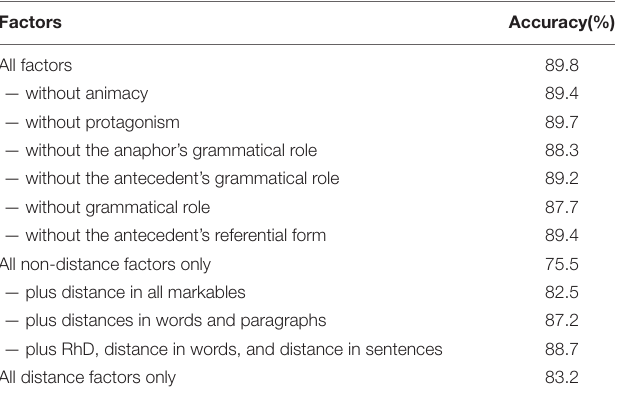
TABLE 7 | The significance of factors in modeling the basic referential choice (boosting with 50 iterations).